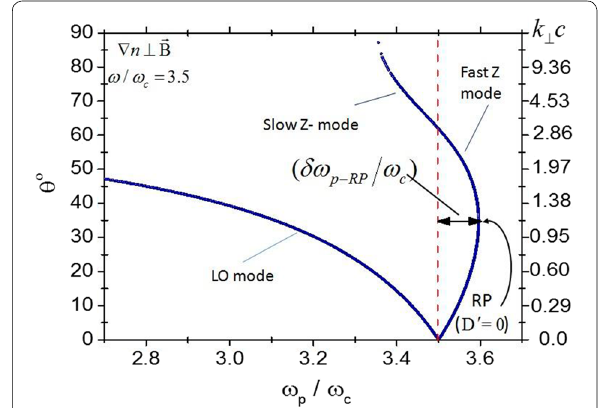
Fig. 5 Variations of wave normal angle and n ⊥ as a function of